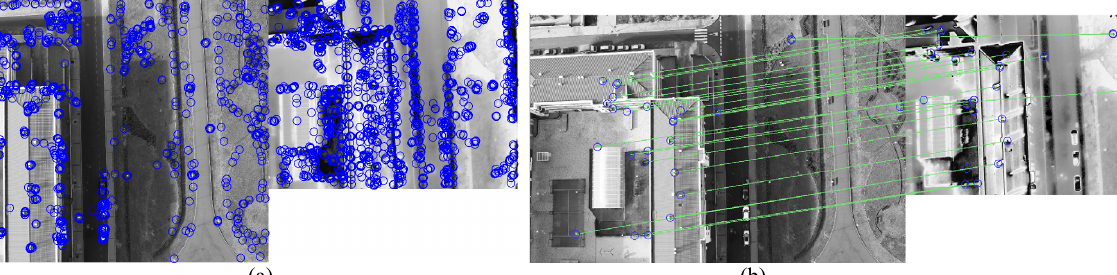
Figure 7: An example of the feature extraction and matching on the multi-modal dataset: feature extraction based on MSD+SIFT (a) and robust matching results using RANSAC (b).